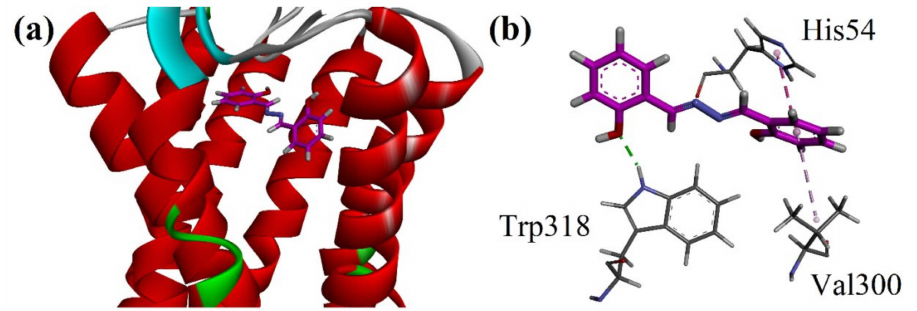
Figure 5. ( a ) The 3D ribbon diagram of isolated salicylalazine into the binding site of µ -opioid (5C1M); ( b ) 3D interaction plot in the binding site of 5C1M showing interactions with key amino acid residues.